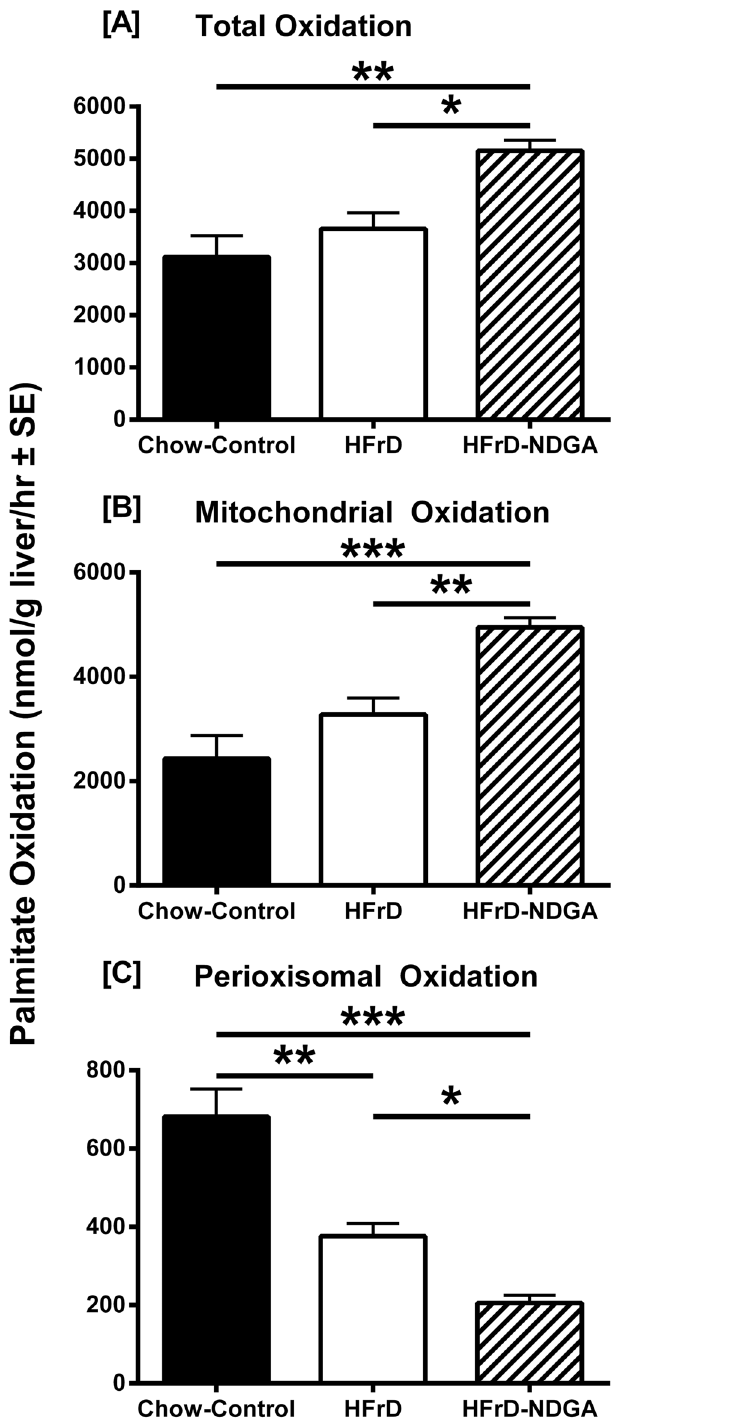
Fig 2. Effect of oral administration of NDGA on hepatic fatty acid oxidation in high-fructose diet (HFrD) fed hypertriglyceridemic rats. Groups of rats were maintained on a chow-diet or HFrD for 8 weeks and, subsequently, HFrD were divided into two groups: one was orally gavaged with NDGA at a dose of 125 mg/kg BW twice a day for 5 days and the other group received vehicle (control). Freshly excised liver samples were processed for the measurement of total, mitochondrial and peroxisomal fatty acid oxidation rates. Values are mean ± SE. * P < 0.05; ** P < 0 . 01; *** P < 0 . 001 . Raw data and statistics are listed in S1 Dataset.